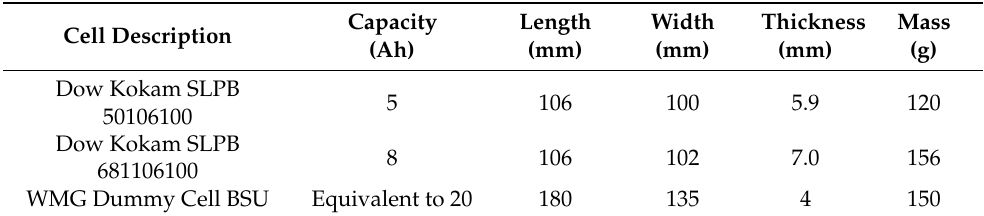
Table 1. Capacity and dimensions of cells used for mechanical tests.